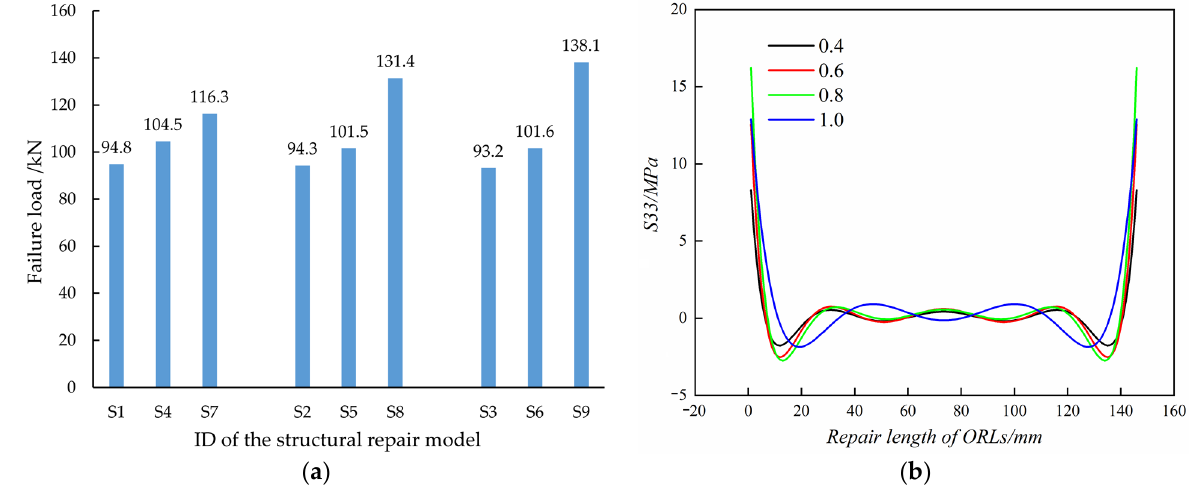
Figure 16. Analysis results of structural repair models: ( a ) failure loads of 9 groups of structural repair models; ( b ) cohesive layer normal stress S33 at different displacement steps.